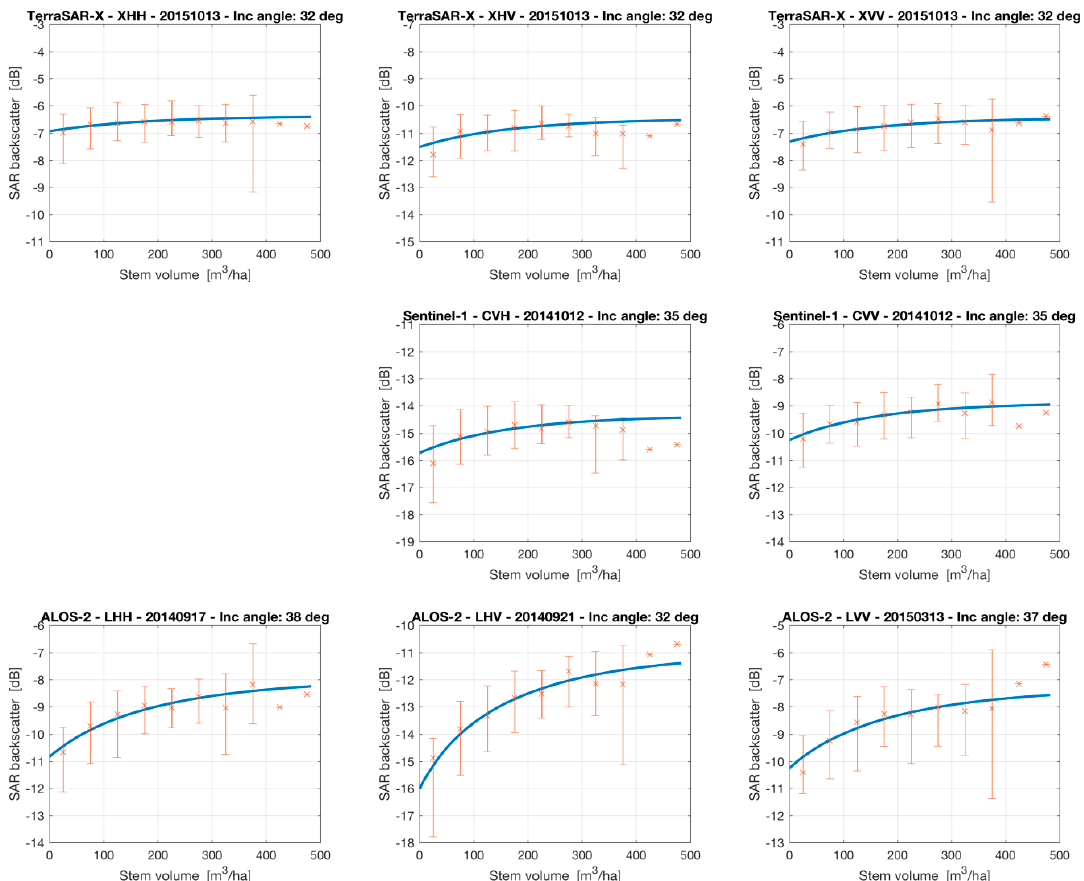
Figure 5. Measured and modeled SAR backscatter as a function of stem volume for the 325 0.03-ha forest plots at Krycklan. For an explanation of symbols and curves, it is referred to the caption of Figure 4.